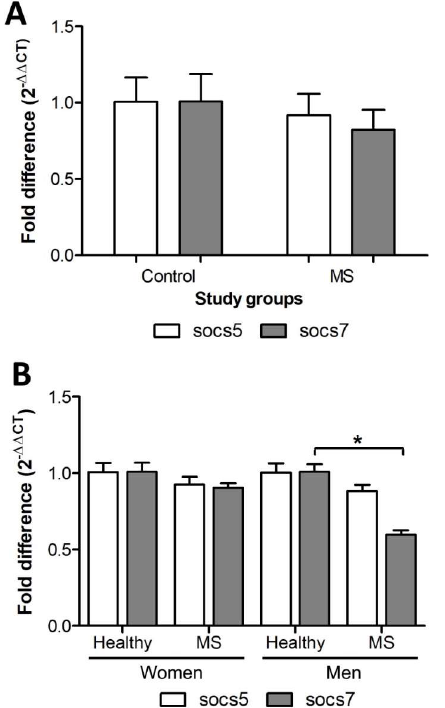
Figure 1. SOCS5 and SOC7 transcript levels were quantified by real time RT-PCR, and the fold difference (2 −DDCT ) between the study groups was calculated. Statistical differences were assessed using the Mann Whitney U test, (*) means p < 0.05. ( A ) Transcription level in MS patients and the control group. ( B ) Transcription level by gender.